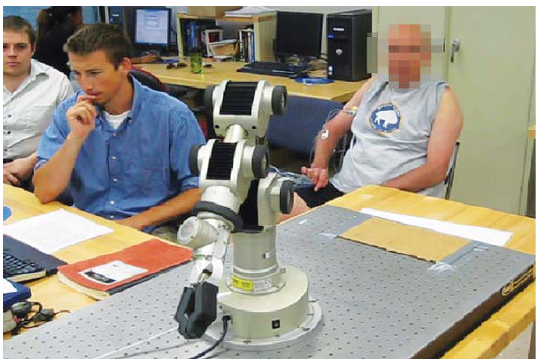
Fig. 3. CCS subject controlling the robotic arm from